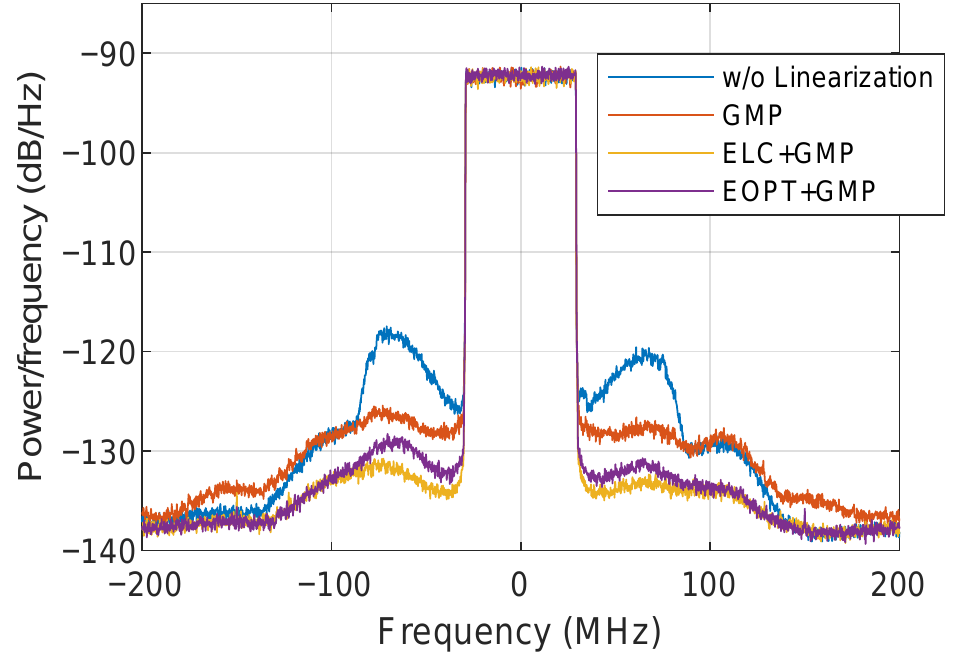
Figure 15. Spectra of the ET PA output signal when combining the use of different envelope lineariza- tion approaches and I-Q